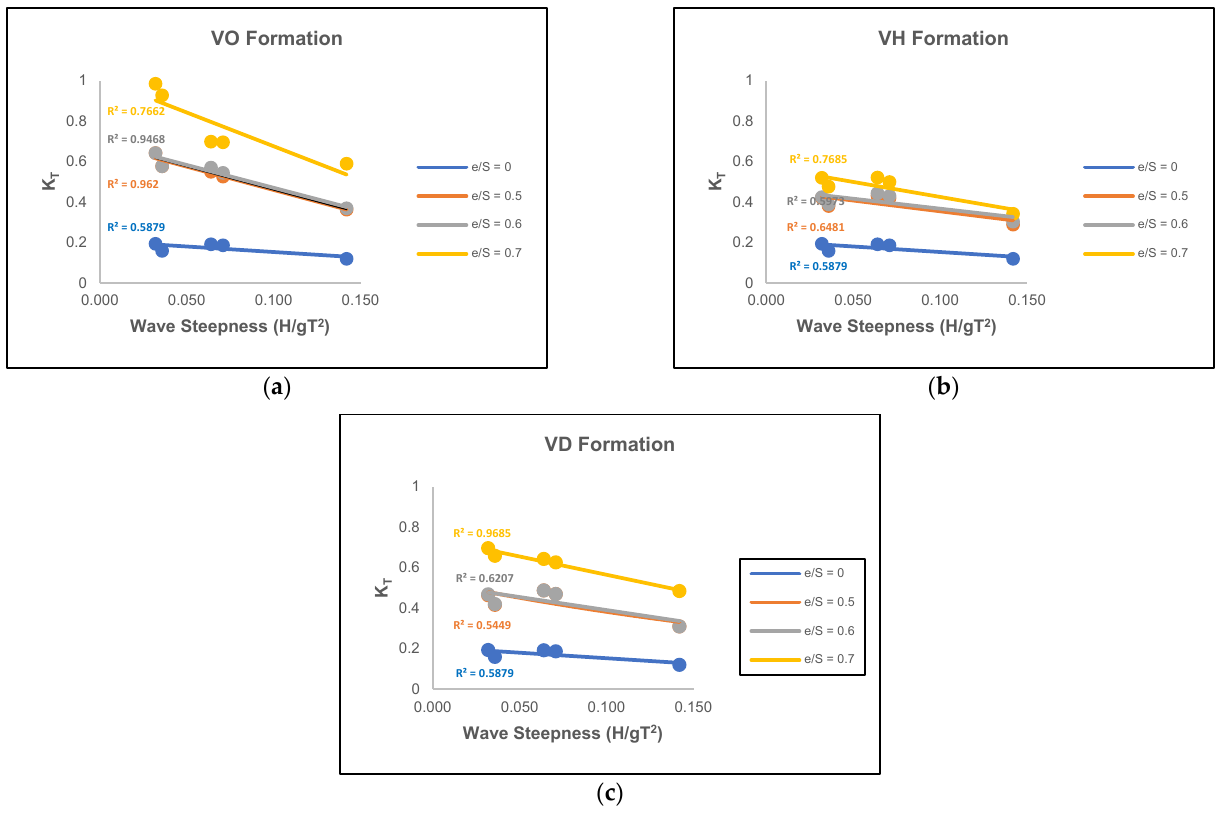
Figure 4. The influences of wave steepness to the wave transmission for ( a ) VO formation ( b ) VH formation, and ( c ) VD formation differentiate by e/S .